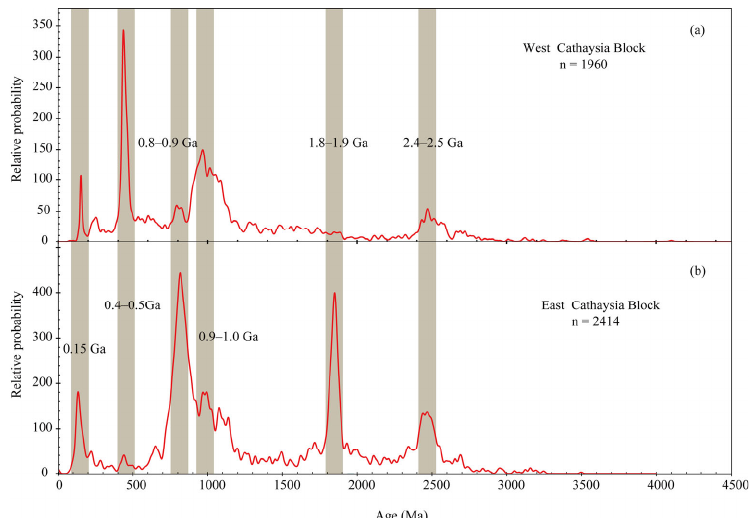
Figure 10. Relative probability density plots of detrital and inherited zircons from rocks of the West Cathaysia Block ( a ) and the East Cathaysia Block ( b ). In addition to the data in this study, the data of the West Cathaysia Block are from [4,11,28,29,81,82,85], respectively. The data of the East Cathaysia Block are from [22,25,31], respectively.